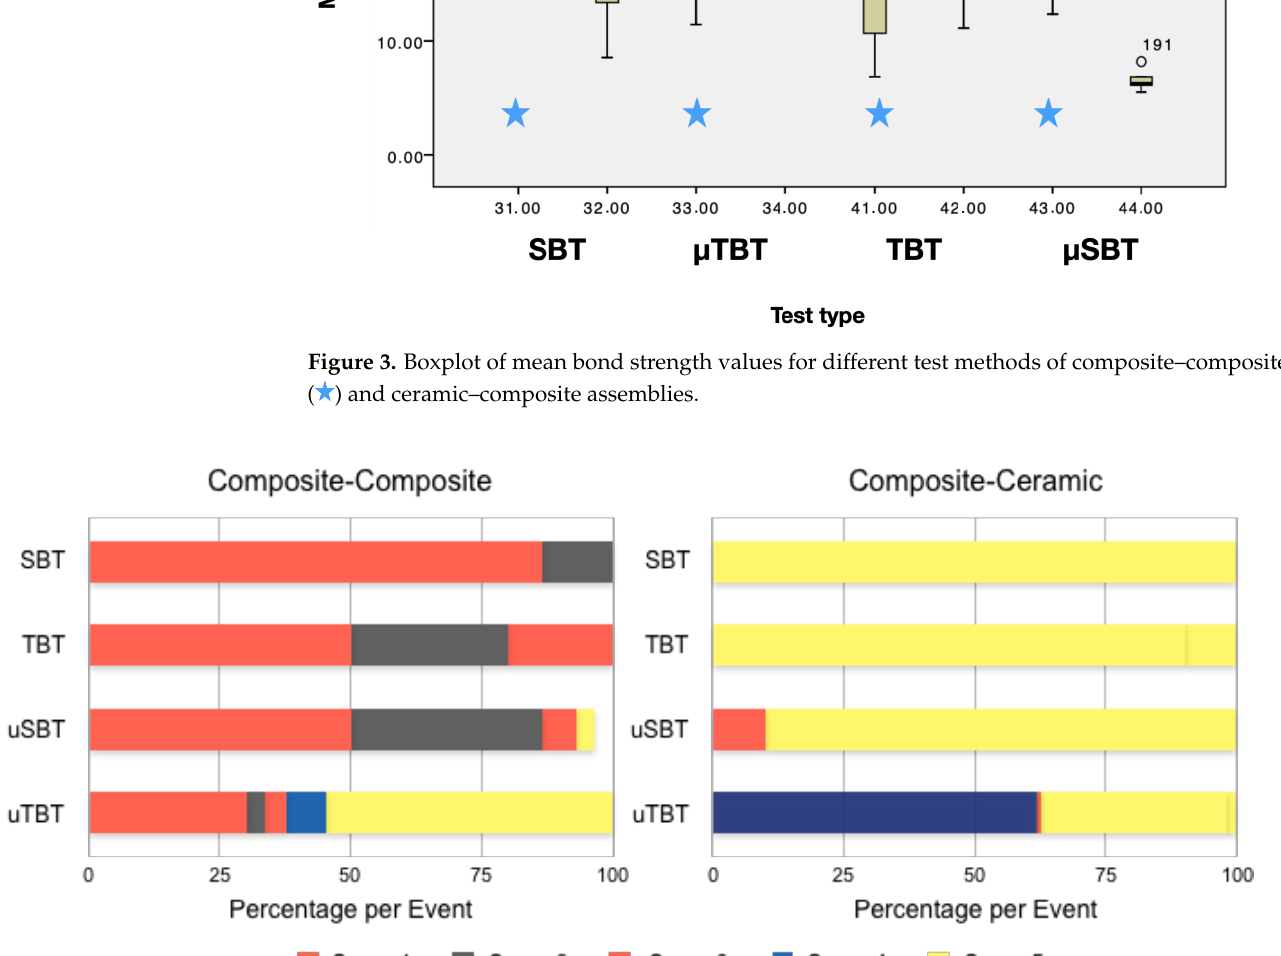
Figure 4. Distribution of failure modes for composite–composite ( left ) and ceramic–composite assemblies ( right ).